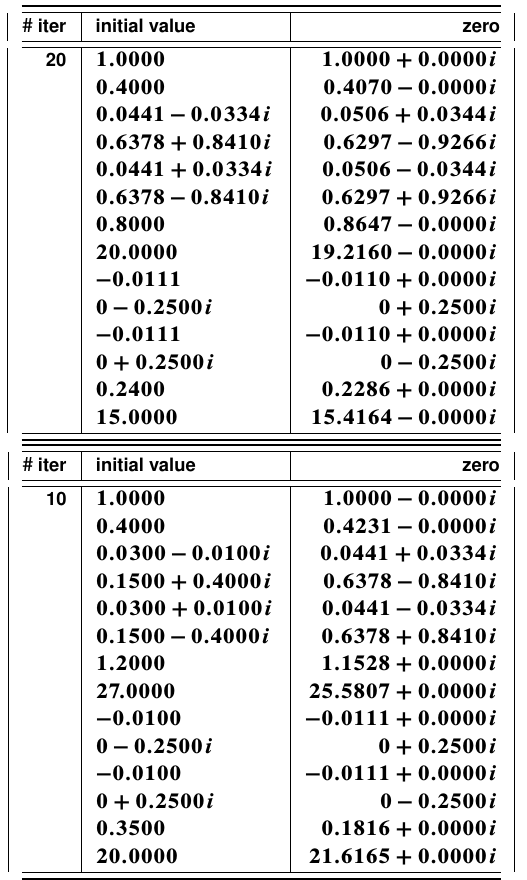
Table 2. Initial values applied to the Newton downhill method and the corresponding convergent results, as well as the number of iterations required to converge